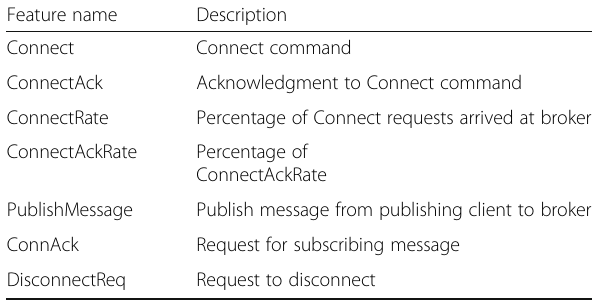
Table 1 Network Traffic